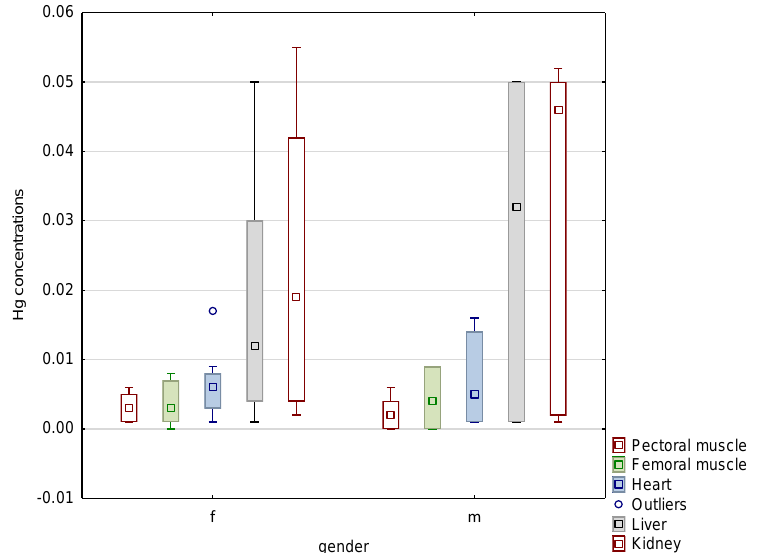
Figure 2. Box-and-whisker plot showing the median values for the mercury concentrations of the organs tested in Eurasian magpies of both genders. Box shows 25 – 75% coefficient, whiskers show minimum and maximum range of non-outliers. Table 3. Correlation coefficients between Hg concentrations in the common woodpigeon organs analyzed. Organ Examined Femoral Muscle Heart Liver Kidney Pectoral muscle